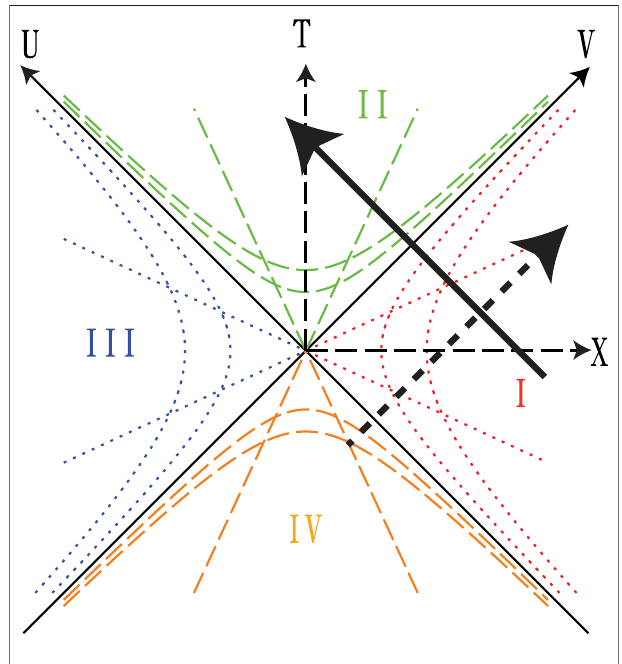
FIGURE 3 | A Schwarzschild black hole in the Kruskal-Szekeres coordinates:RegionIisoutside,whileregionIIisinsidethehorizon.RegionsIII and IV are copies of regions I and II. The U and V axes are along the horizon. The dashed and solid arrow lines represent constant U and V trajectories. The other lines represent constant r and t trajectories.